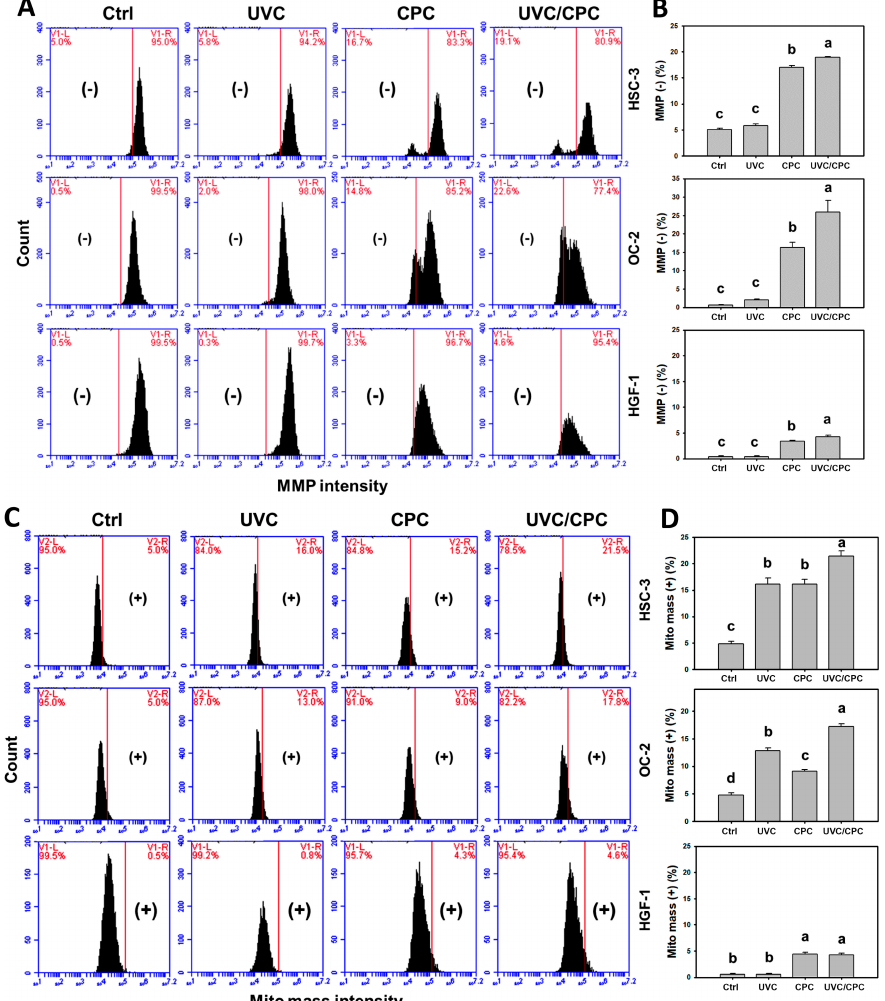
Figure 3. MMP and mitochondrial mass change of oral cancer and normal oral cells following UVC and/or CPC treatments. Oral cancer (HSC-3 and OC-2) and oral normal (HGF-1) cells were arranged to treat with vehicle control, UVC (10 J/m 2 ), CPC (5 µ g/mL), and UVC/CPC (10 J/m 2 and 5 µ g/mL). Flow cytometry was performed after 24 h treatment. MMP ( − ) and Mito mass (+) populations were labeled with (+) and ( − ), respectively, i.e., high and low intensity. ( A ) MMP patterns. ( B ) Statistics for ( A ). ( C ) Mito mass patterns. ( D ) Statistics for ( C ). Data, mean ± SD ( n = 3). Based on multiple comparisons after Tukey’s HSD Tests, different tests labeled without the same top letters differed significantly ( p < 0.05). For the example of ( D ) Mito mass in HSC-3 cells, UVC and CPC showing “b, b” indicated a non-significant difference between each other. UVC/CPC and CPC in HSC-3 cells showing “a, b” without overlapping letters indicating a significant difference between each